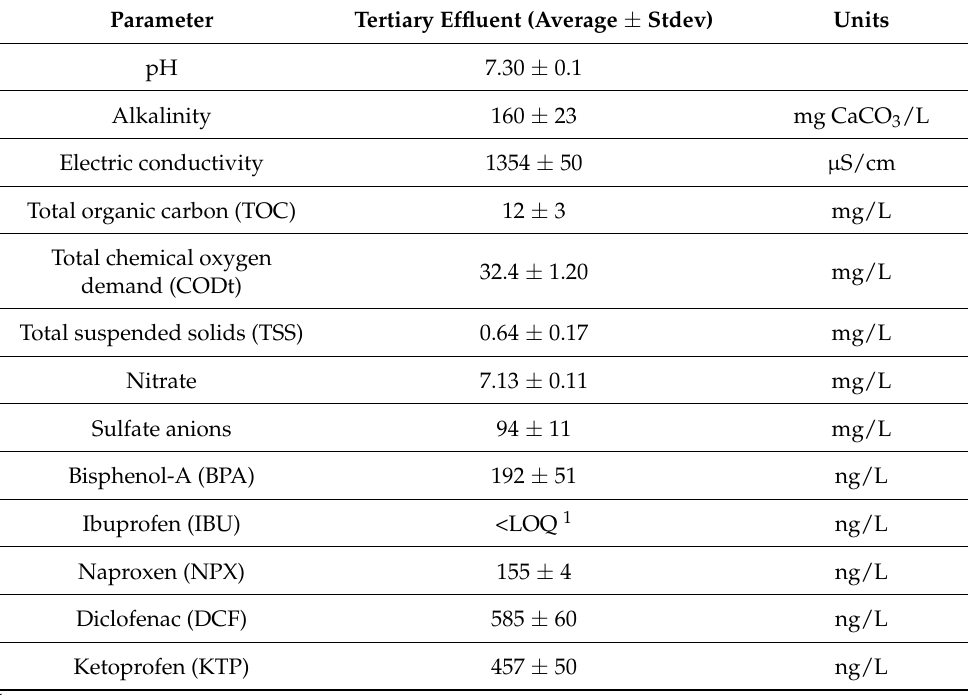
Table 1. Wastewater characteristics used in the